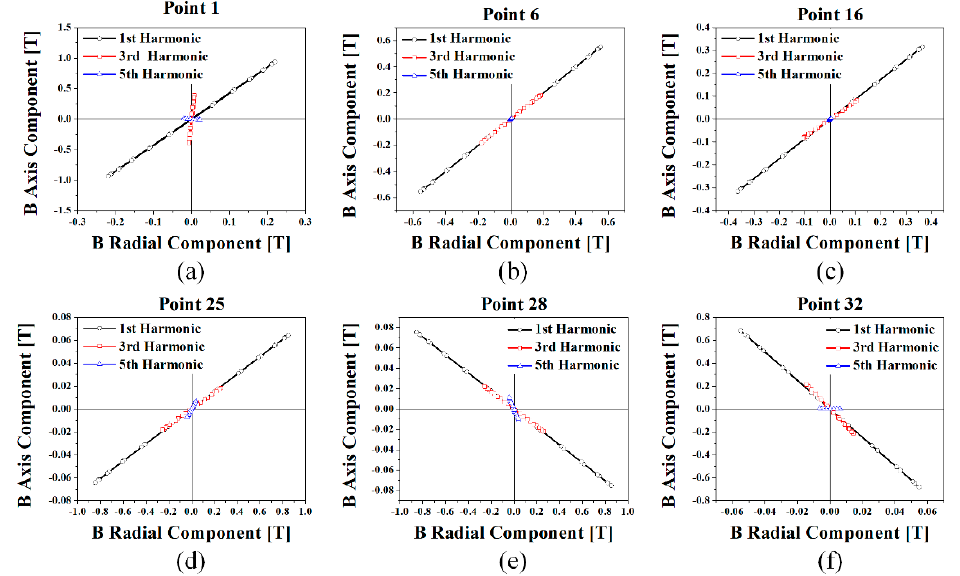
Figure 9. Magnetic field behavior according to stator region: ( a ) region 1, ( b ) region 6, ( c ) region 16, ( d ) region 25, ( e ) region 28, ( f ) region 32.